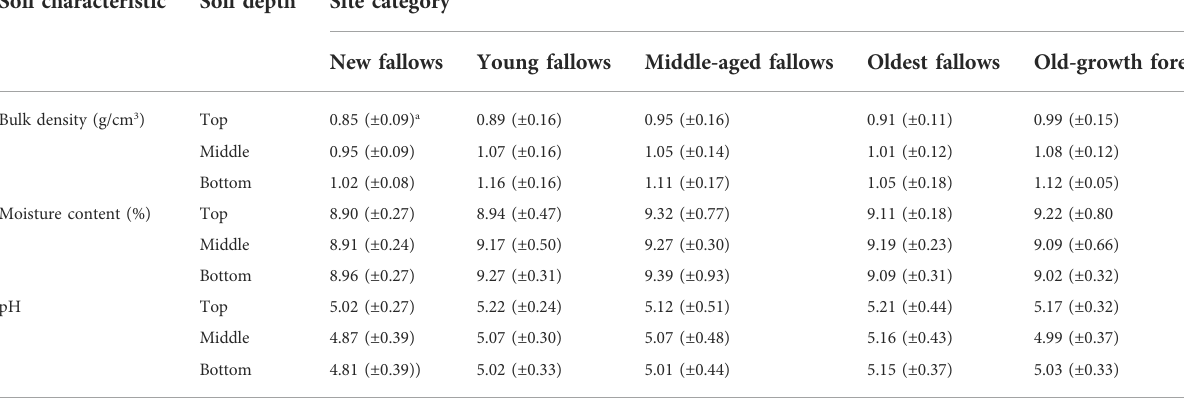
TABLE 2 Soil physical and chemical characteristics of our study sites on Leyte Island, the Philippines. Soil